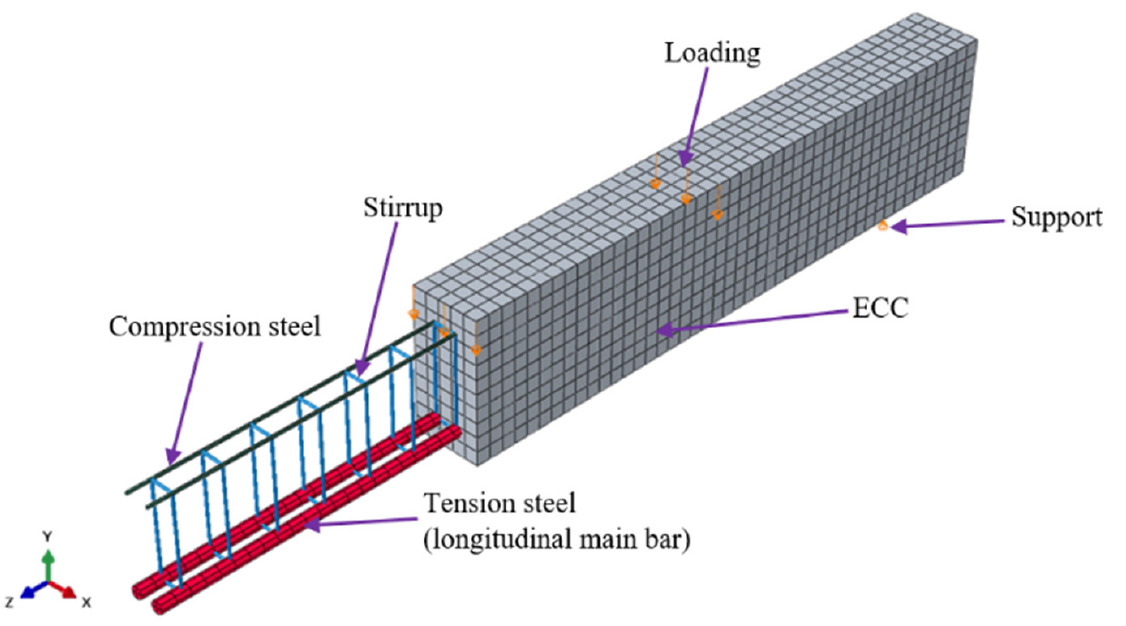
Figure 7. Meshing of elements used.